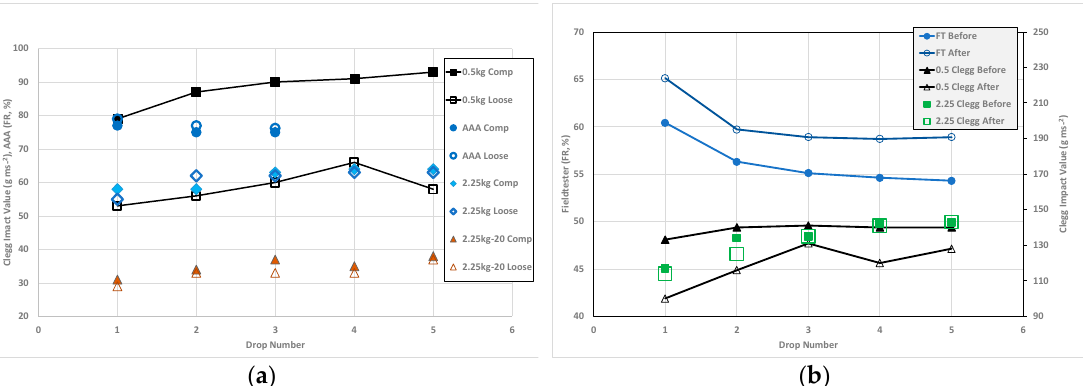
Figure 5. ( a ) Laboratory impact test data on a rubber infilled carpet for “loose” and “compacted” (Comp) states. ( b ) Field data (for a specific position, and typical of all positions) for 5 repeated impacts with the Fieldtester (FT) and CIST devices, showing results for “before” and “after” a deep decompaction of the